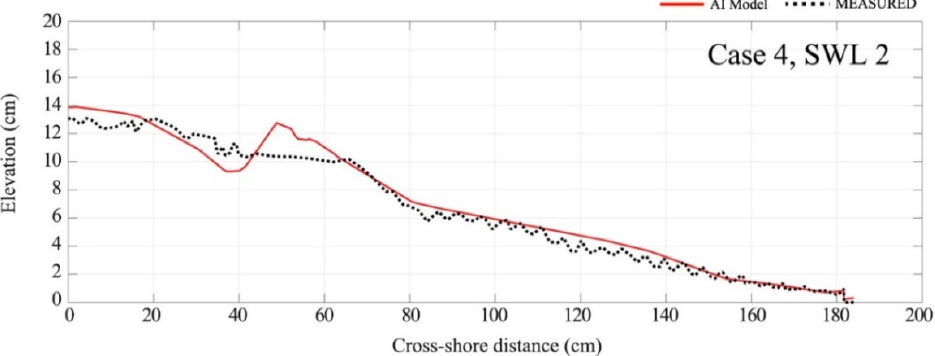
Figure 20. Case 4 SWL 1 comparison of the ANN prediction and measured from the physical test.